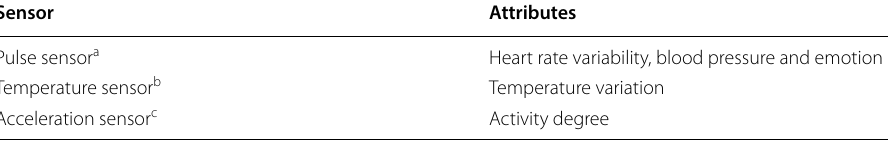
Table 1 Different healthcare sensors